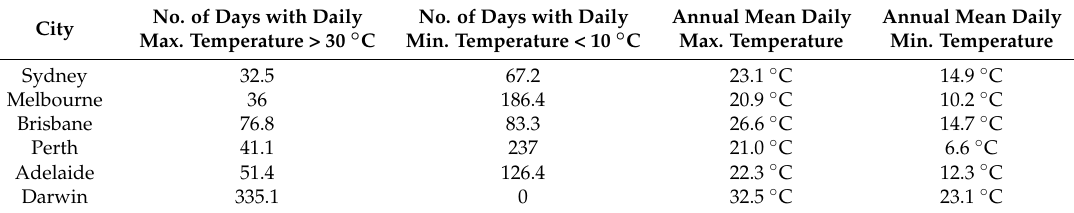
Table 1. Statistics of the hot and cold days in major Australian cities (all numbers are averaged over 2005–2015) *. No. of Days with Daily No. of Days with Daily Annual Mean Daily City Max. Temperature > 30 ◦ C Min. Temperature < 10 ◦ C Max.